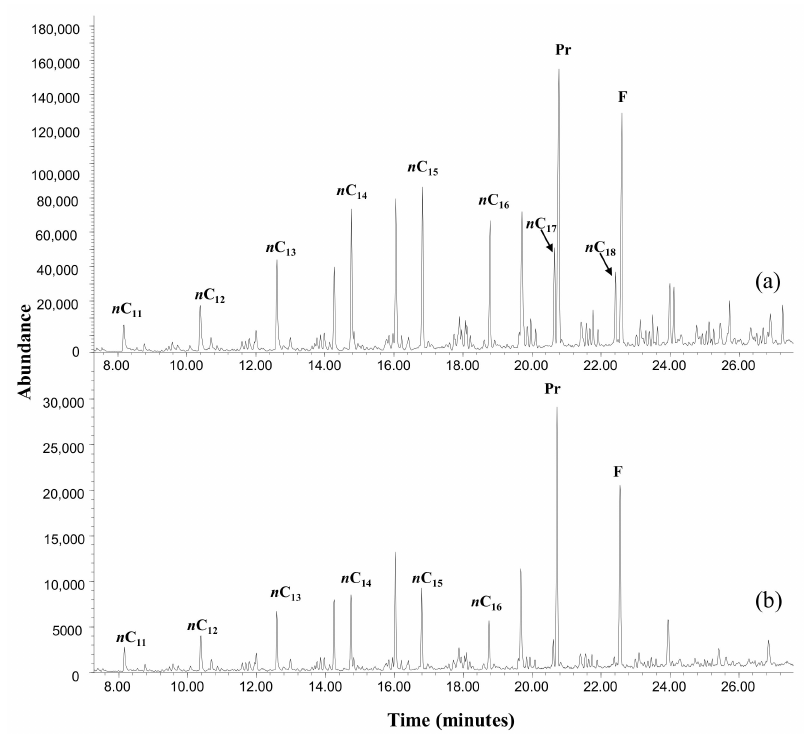
Figure 4. Chromatographic fingerprints of m / z 85 of ( a ) remaining oil after 120 h in the abiotic test and ( b ) remaining oil after 120 h of Y. lipolytica ’s growth in seawater with 1% v / v of